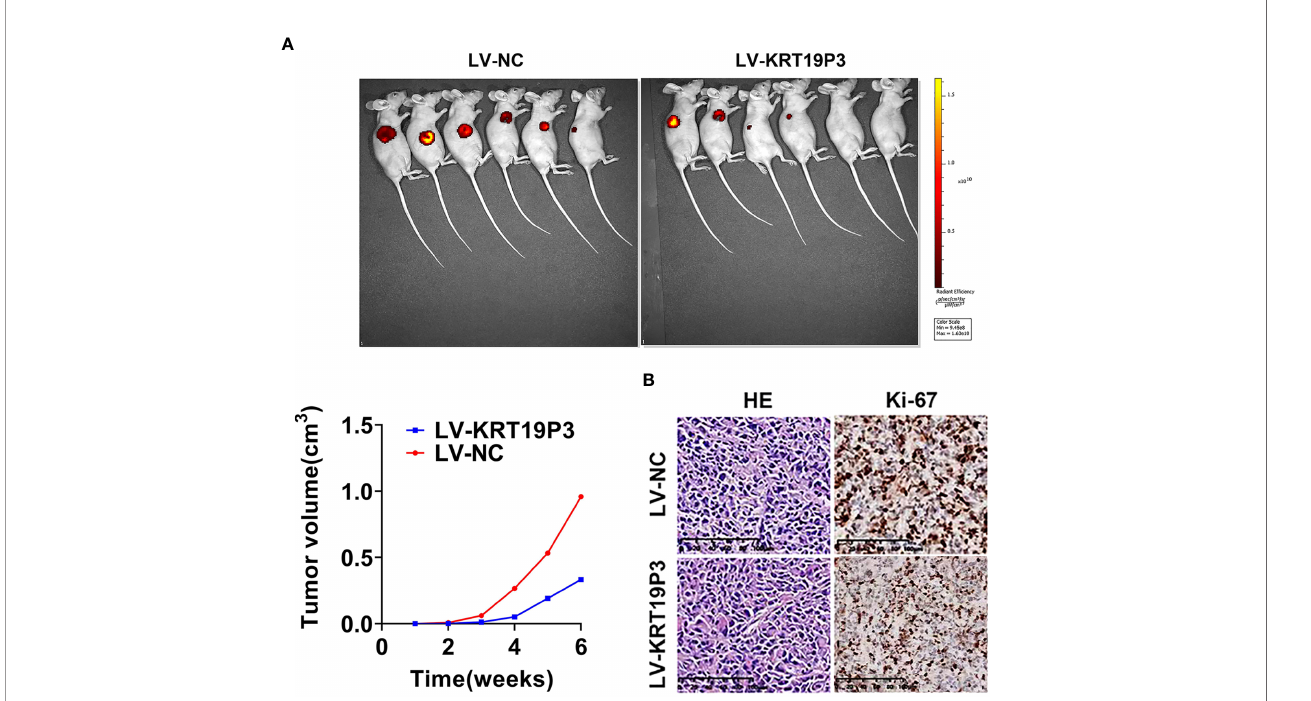
FIGURE 2 | LncRNA KRT19P3 inhibited BC growth in vivo. (A) A stable MDA-MB-231 cell line overexpressing KRT19P3(LV-KRT19P3) was constructed and injected under the subcutaneous of nude mice to establish a xenograft tumor model with 6 mice in each group. Moreover, primary tumor growth was measured every week after injection. The tumor volumes in the LV-KRT19P3 group were signi fi cantly smaller than those in the LV-NC group. (B) Immunohistochemistry for Ki-67 detection revealed that cancer cells in the LV-NC group showed a higher positivity rate than those in the LV-KRT19P3 group (magni fi cation ×